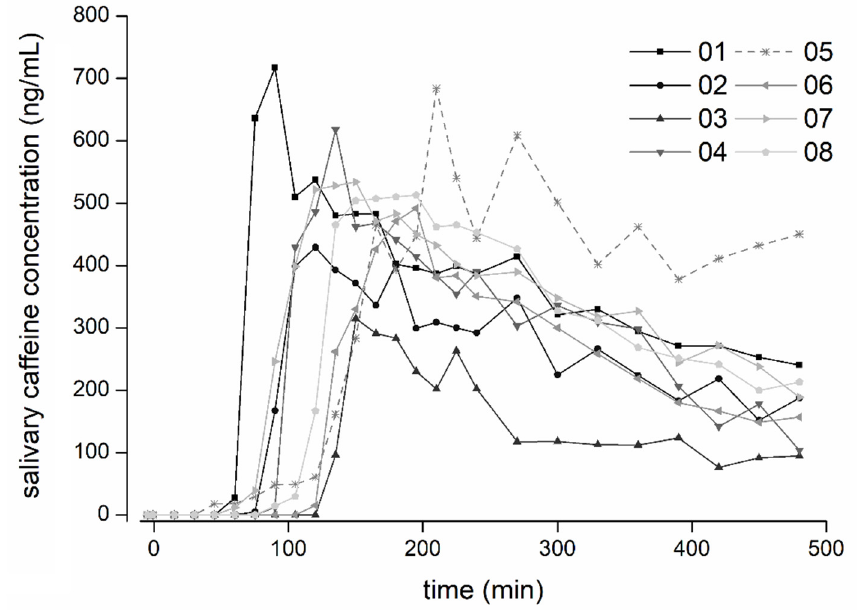
Figure 5. Salivary caffeine concentrations of all subjects. Profile of the capsule that disintegrated in the colon is additionally highlighted by a dashed line (volunteer 05).